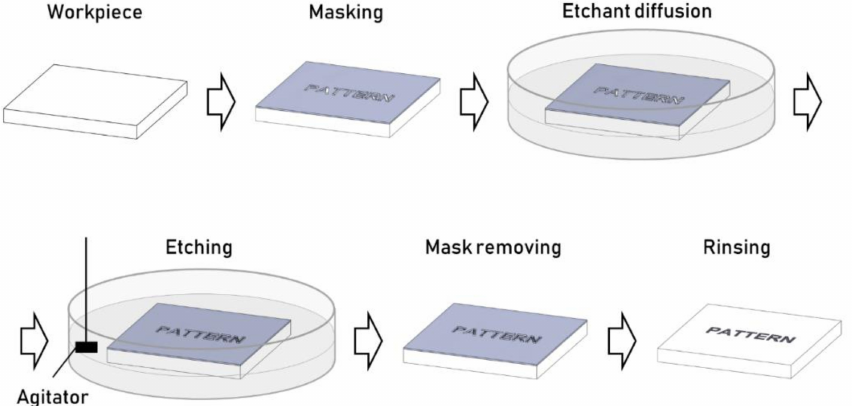
Figure 4. Process steps for a typical chemical etching process.